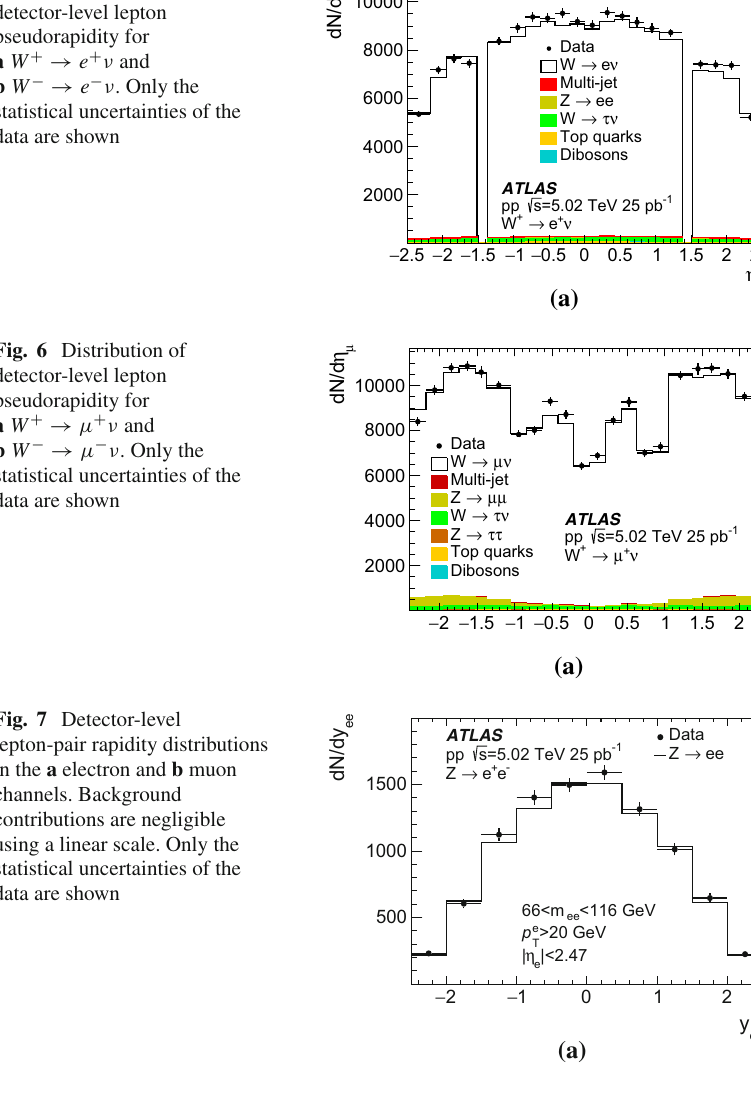
Fig. 5 Distribution of detector-level lepton pseudorapidity for a W + → e + ν and b W − → e − ν . Only the statistical uncertainties of the data are shown